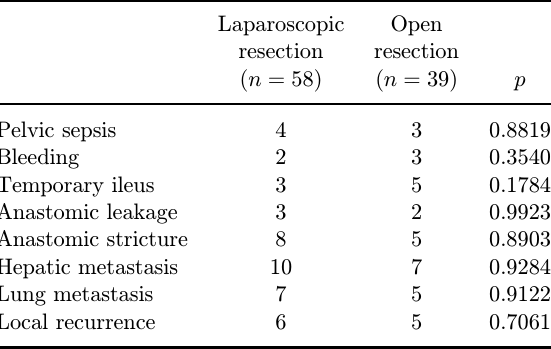
Table 2. Operative procedure and clinical character- istics of postoperative.